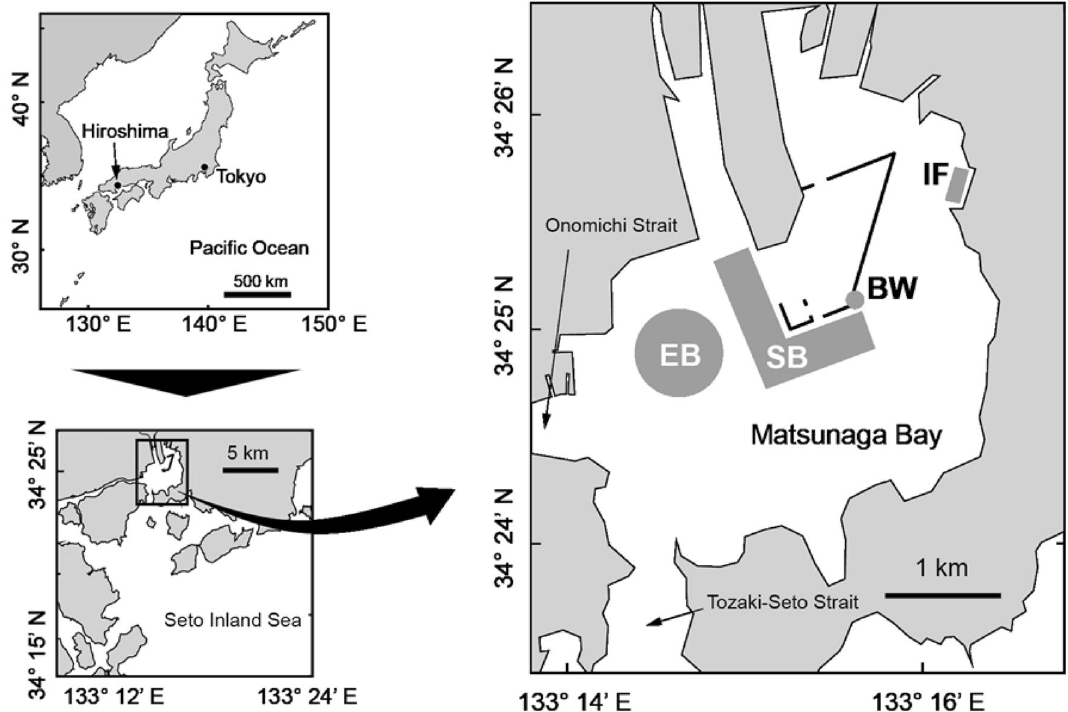
Figure 1. Locations of sampling sites in Matsunaga Bay, Hiroshima, Japan. This map was created based on coordinate data from Google (http://www.gis-tool.com/mapvi ew/mapto coord inate s.html). The four habitats examined in this study are indicated by BW (breakwater wall; grey circle), EB (eelgrass bed; grey circle), IF (intertidal flat; grey rectangle), and SB (subtidal bottom; grey